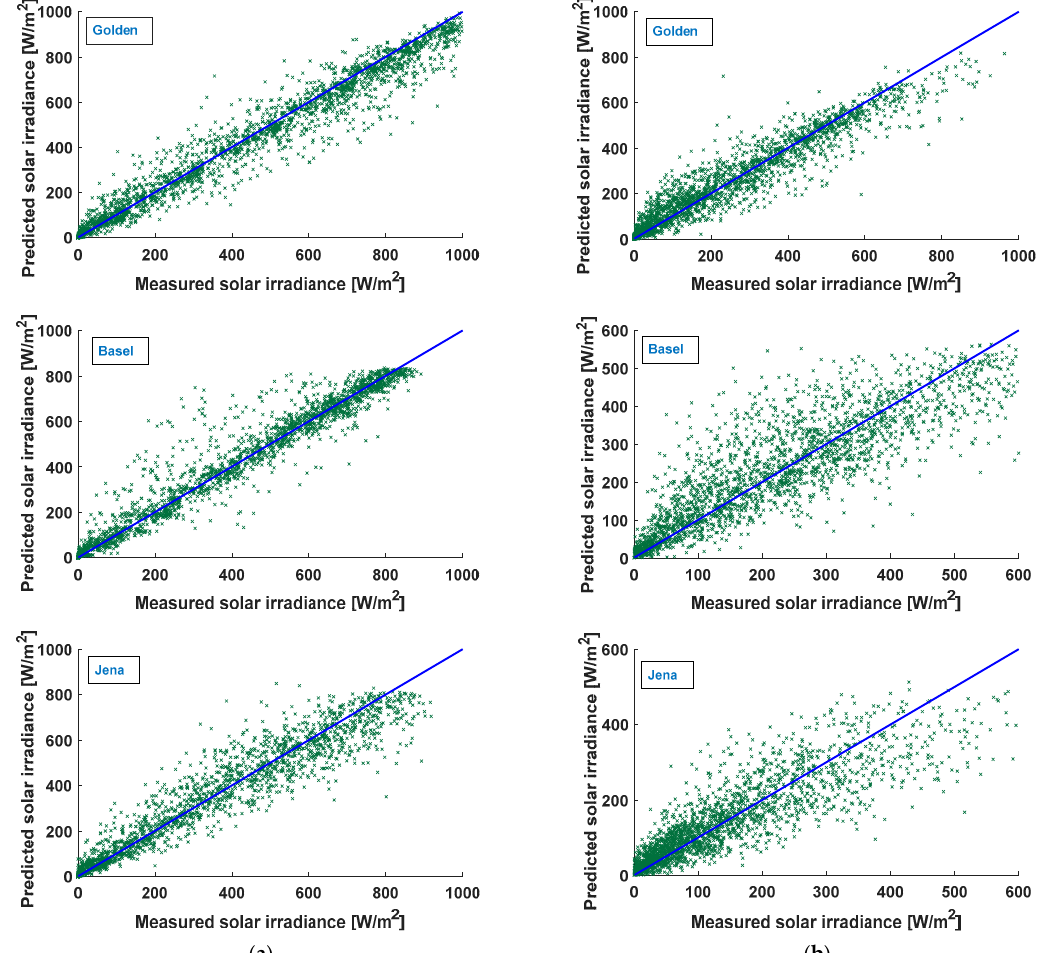
Figure 10. Scatter plots of the measured SI value at each location against that predicted by the hybrid LSTM-RNN model for ( a ) sunny and ( b ) cloudy days.